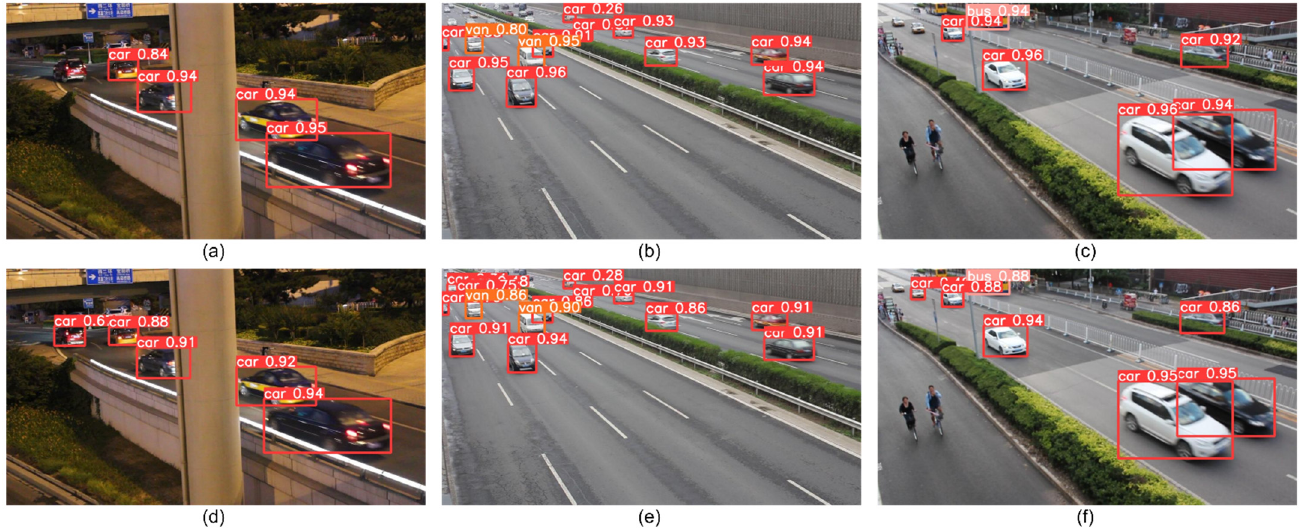
Figure 16. Comparison of YOLOv5s and RD-YOLO detection results on the UA-DETRAC dataset. ( a ) YOLOv5s detection result of No. 1 image. ( b ) YOLOv5s detection result of No. 2 image. ( c ) YOLOv5s detection result of No. 3 image. ( d ) RD-YOLO detection result of No. 1 image. ( e ) RD-YOLO detection result of No. 2 image. ( f ) RD-YOLO detection result of No. 3 image.